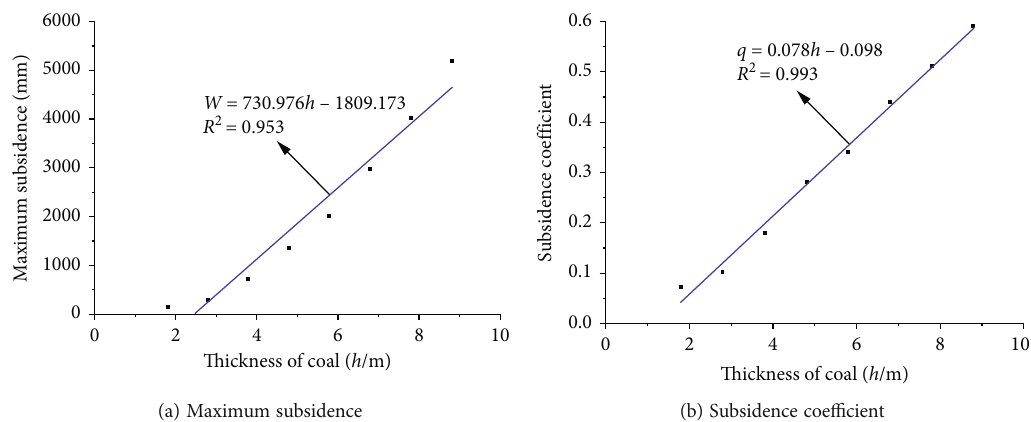
Figure 11: Fitting curve of maximum subsidence/subsidence coe ffi cient and thickness of coal.